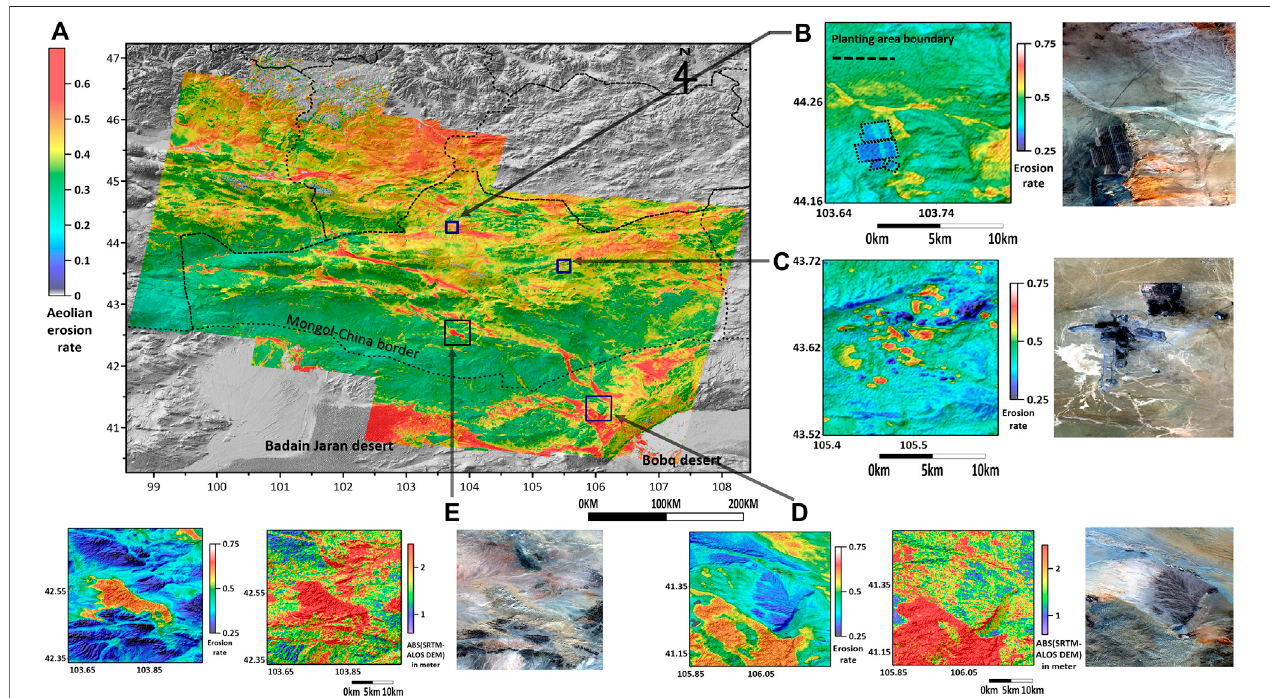
FIGURE2| (A) The surfaceerosionmap from the fi rstPCA PCand further datainterpretation. Thelandmarkareasover planted area (B) and the Tavan Tolgoicoal mine (C) proved the reliability of the constructed map. The validations using the DEM residuals are shown in (D,E) . The correlation values of those cases are 0.501 and 0.404,